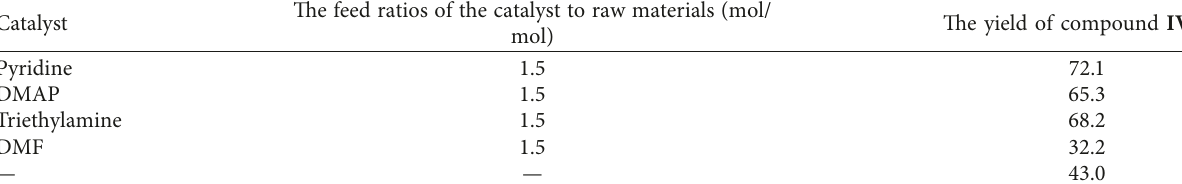
Figure 6: Initial one-pot method. Table 1: The impact of catalyst on yield.